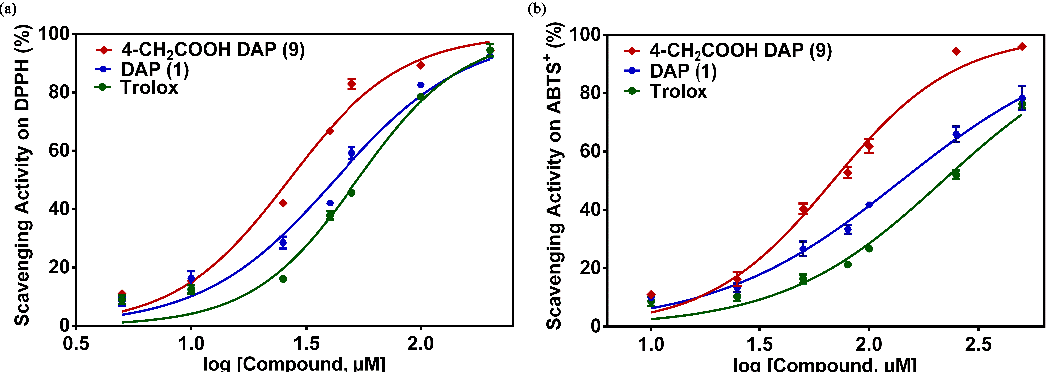
Figure 3. Concentration-response curve for the radical-scavenging activity of 4-CH 2 COOH DAP ( 9 ), daphnetin (DAP) ( 1 ), and positive control compound Trolox in 2,2 ′ -diphenyl-1-picrylhydrazyl (DPPH) ( a ) and 2,2 ′ -azinobis-(3-ethylbenzthiazoline-6-sulfonate) cation (ABTS + ) ( b ) assays.